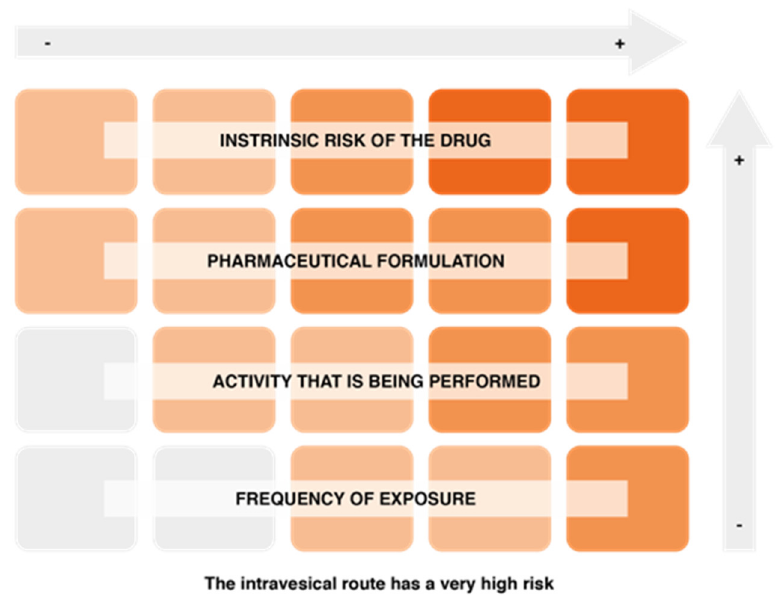
Figure 5. Factors conditioning the risk of exposure to hazardous drugs.